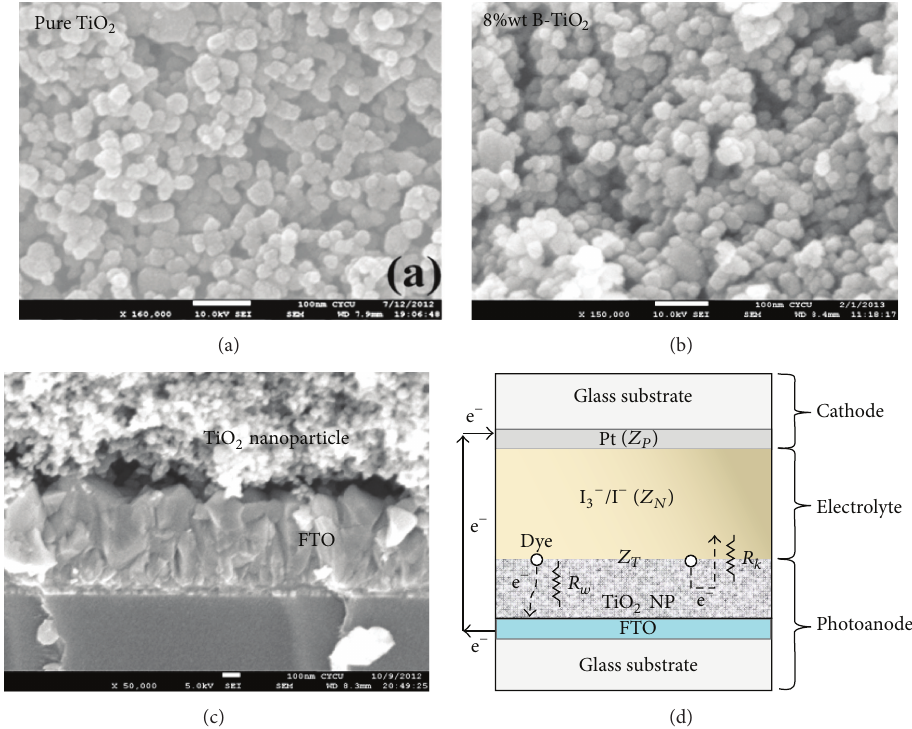
Figure 1: SEM images of the TiO 2 nanoparticles: (a) BT-0, (b) BT-8, (c) interface between TiO 2 nanoparticle and FTO substrate, and (d) schematic drawing of assembling DSSC structure, electron transport, and recombination pathways.